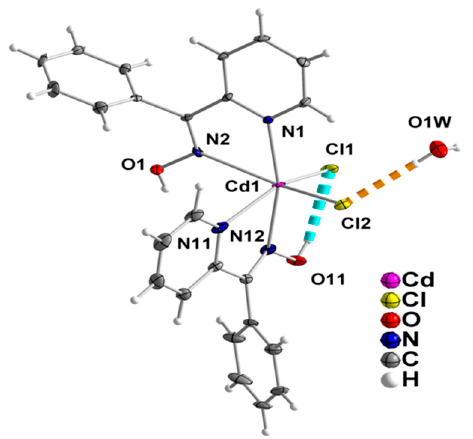
Figure 2. The molecules [CdCl 2 (phpaoH) 2 ] and H 2 O that are present in the crystal structure of 1 · H 2 O. The thermal ellipsoids are presented at the 50% level. Only diagnostic atoms have been numbered. Dashed lines indicate hydrogen bonds in which the symmetry operation is x, y, z. Through the hydrogen bond indicated with the orange color, molecular pairs of the type {[CdCl 2 (phpaoH) 2 ] − H 2 O} are formed in the crystal.